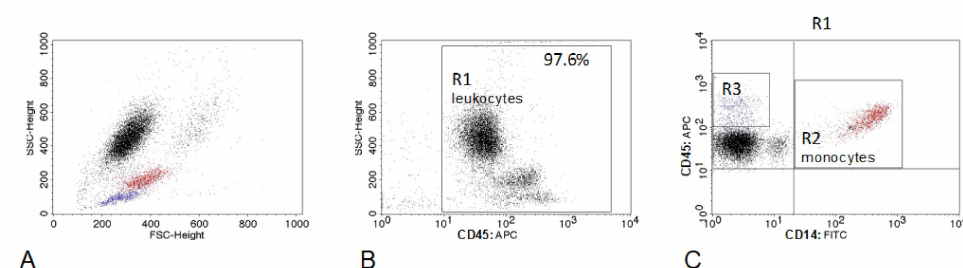
Figure 1. Representative dot plots depicting the gating strategy of canine peripheral blood leukocytes. ( A ) Forward scatter (FSC-hight) vs. side scatter (SSC-hight) dot plot showing leukocyte populations (population colors result from the regions set on the cytogram C); ( B ) debris and non-cellular elements were eliminated by setting a region defining CD45+ leukocytes (R1) on the SSC vs. CD45:APC dot plot; ( C ) leukocyte populations “(R1)” were analyzed on the CD45:APC/CD14:FITC dot plot in order